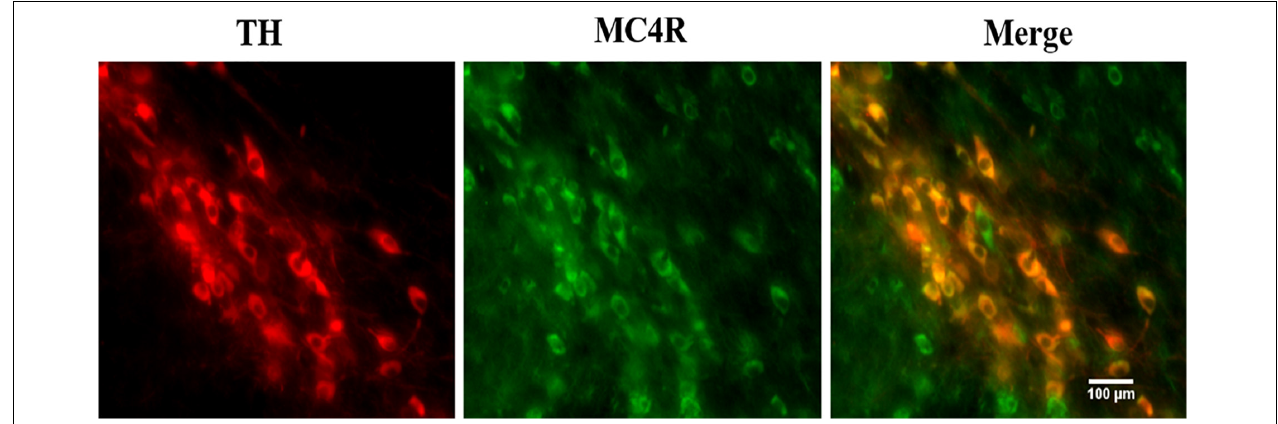
FIGURE 2 | Double staining of TH and MC4R in the mouse SNpc ( n = 6). The images were obtained by immunofluorescence microscopy. TH, tyrosine hydroxylase; MC4R, melanocortin 4 receptor; SNpc, substantia nigra pars compacta.